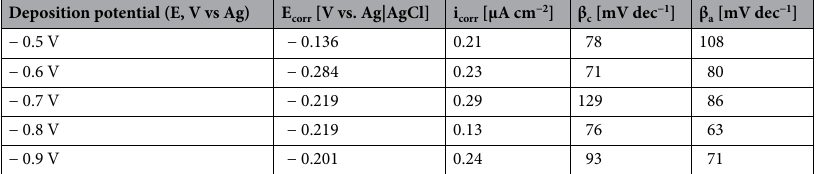
Deposition potential (E, V vs